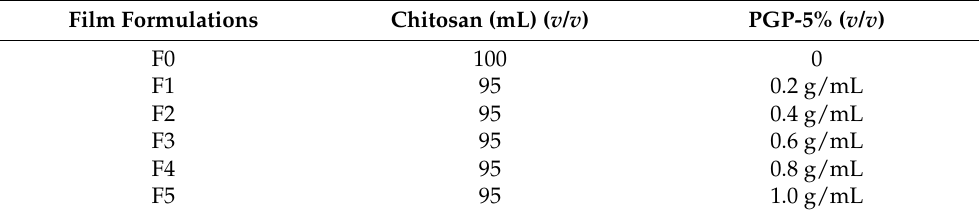
Table 1. Formulations of chitosan-based edible coating enriched with